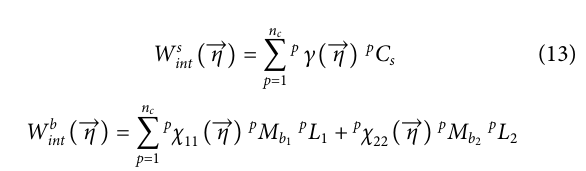
FIGURE11| Numericalandexperimentaldeformedsamplegeometryof the cantilever bending